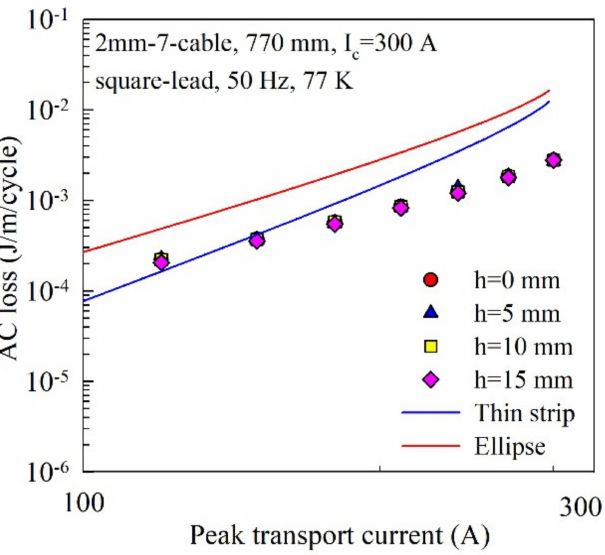
Figure 7. Dependence of height of voltage-lead configuration on AC loss for 2 mm − 7 −